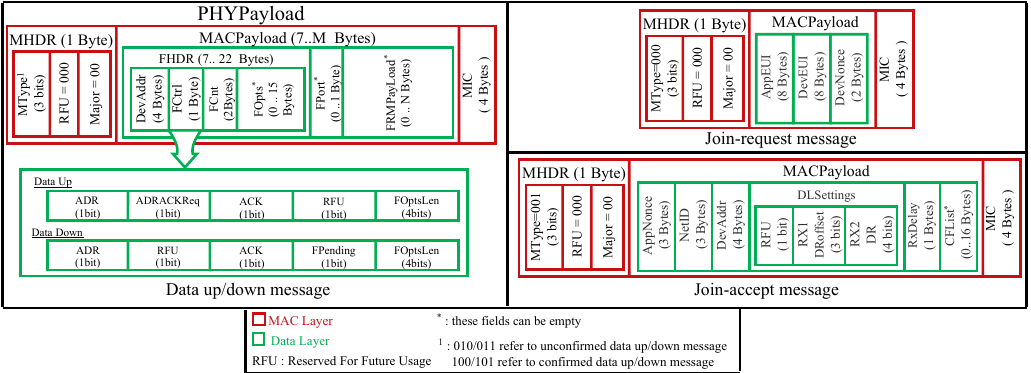
Figure 3. Message structures for LoRaWAN v1.0.x (MAC